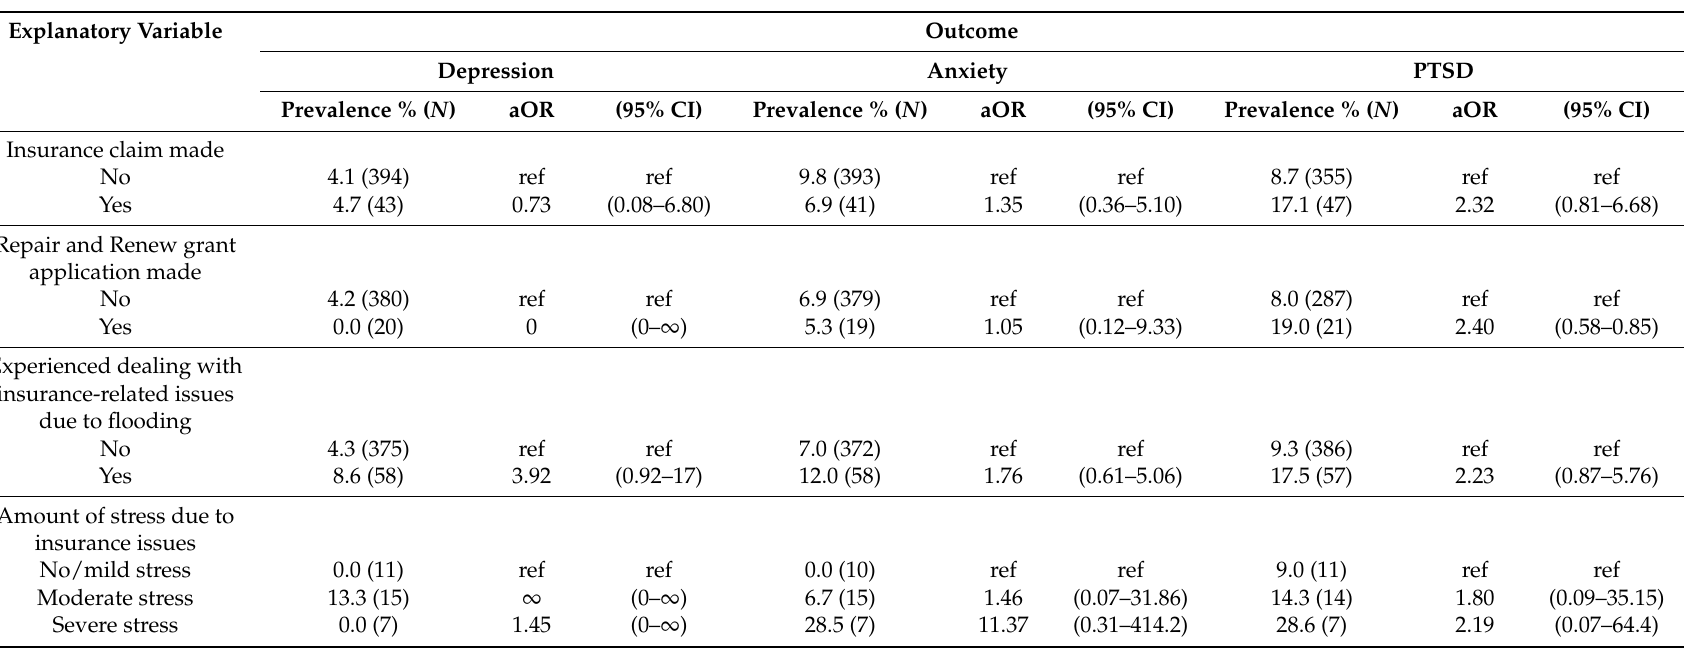
Table 4. Association between probable mental health outcomes and insurance-related factors for disrupted